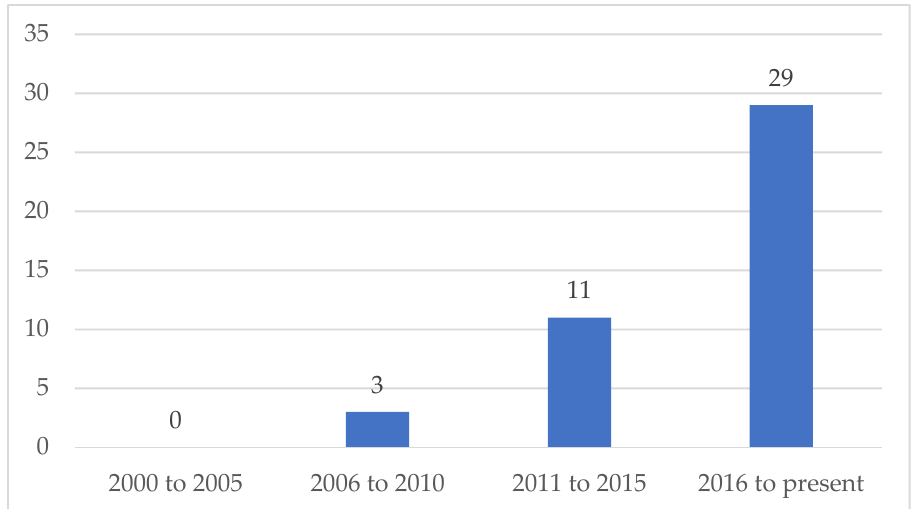
Figure 3. Distribution of articles every five years ( n = 43).